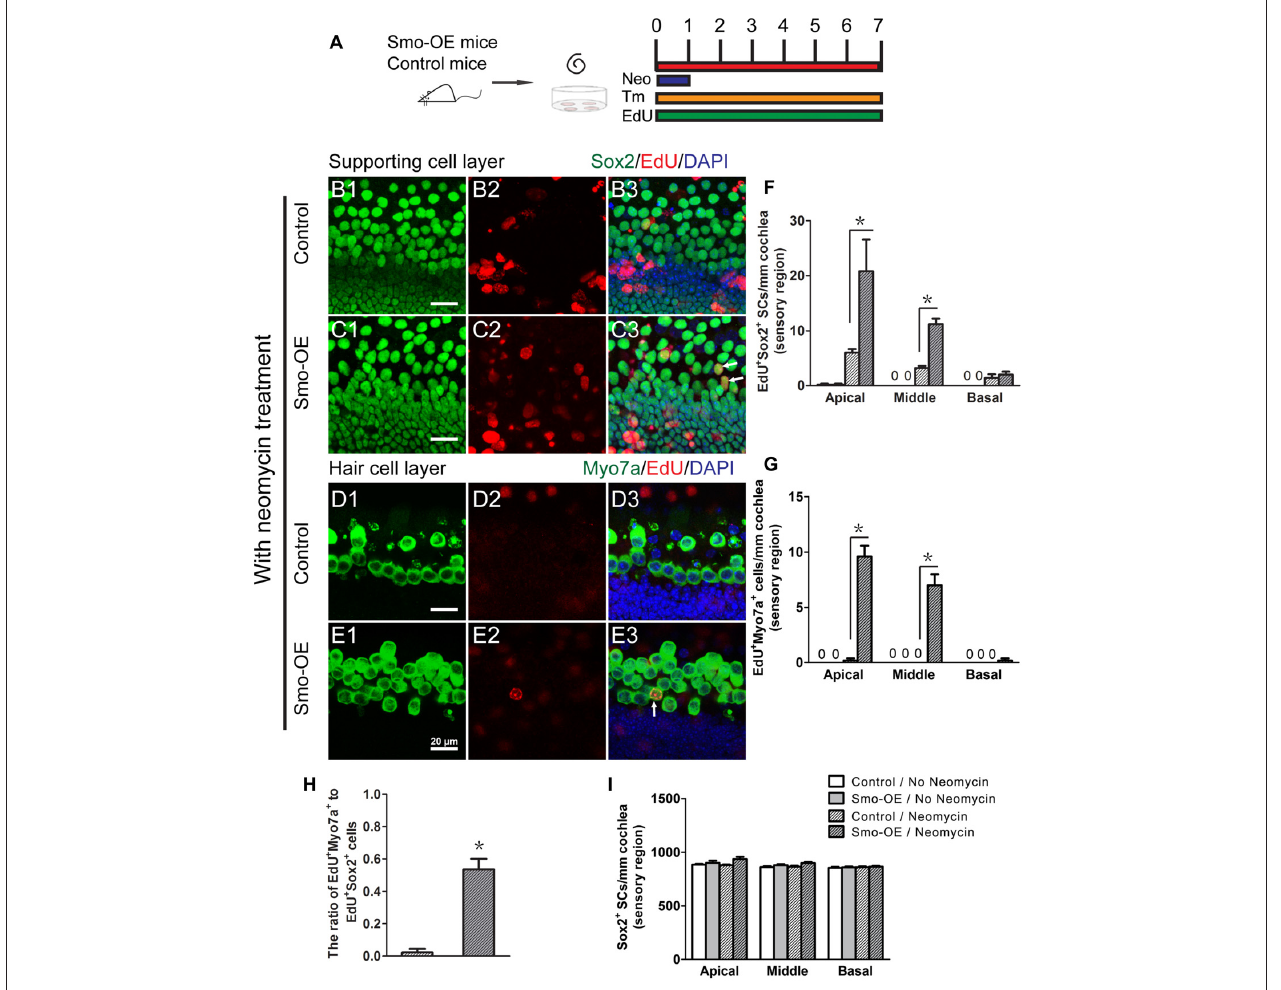
FIGURE 4 | Forced activation of Hedgehog signaling promoted in situ supporting cell proliferation and HC regeneration after neomycin treatment. (A) The diagram for the assay. Cochlear epithelium samples were dissected from P2 Smo-OE and control mice and then cultured in DMEM/F12 media with N2 and B27. The explanted cochleae were treated with 0.5 mM neomycin sulfate (Neo) for 24 h. 4-OH tamoxifen (Tm) and EdU were added to the culture media throughout the entire culture period to induce the Cre activity and to label proliferating cells, respectively. (B,C) Representative immunofluorescence images of the supporting cell layer in the control and Smo-OE cochlear epithelia after neomycin treatment. (D,E) Representative immunofluorescence images of the HC layer in the control and Smo-OE cochlear epithelia after neomycin treatment. (F) The number of EdU+Sox2+ cells significantly increased in the Smo-OE group compared with the control group. (G) The number of EdU+Myo7a+ cells significantly increased in the Smo-OE group compared with the control group. (H) The ratio of EdU+Myo7a+ cells to EdU+Sox2+ cells in the Smo-OE and control groups. (I) The total number of Sox2+ supporting cells (SCs). Data are presented as means ± SE. N = 5, ∗ p < 0.05 vs. the control group with neomycin treatment. Scale bars (B–E) are 20 µ